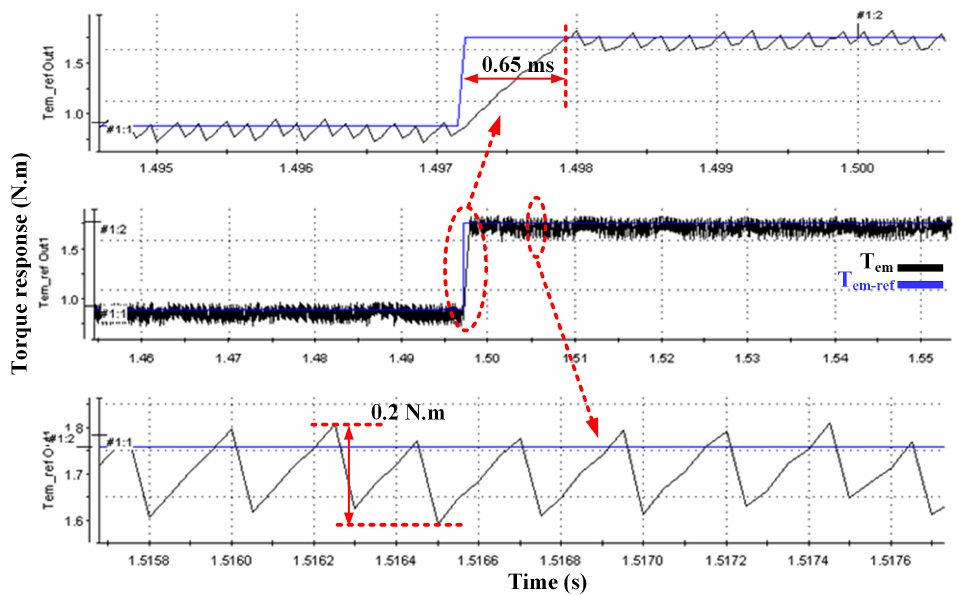
Figure 23. Experimental results of the torque ripples of the improved strategy.